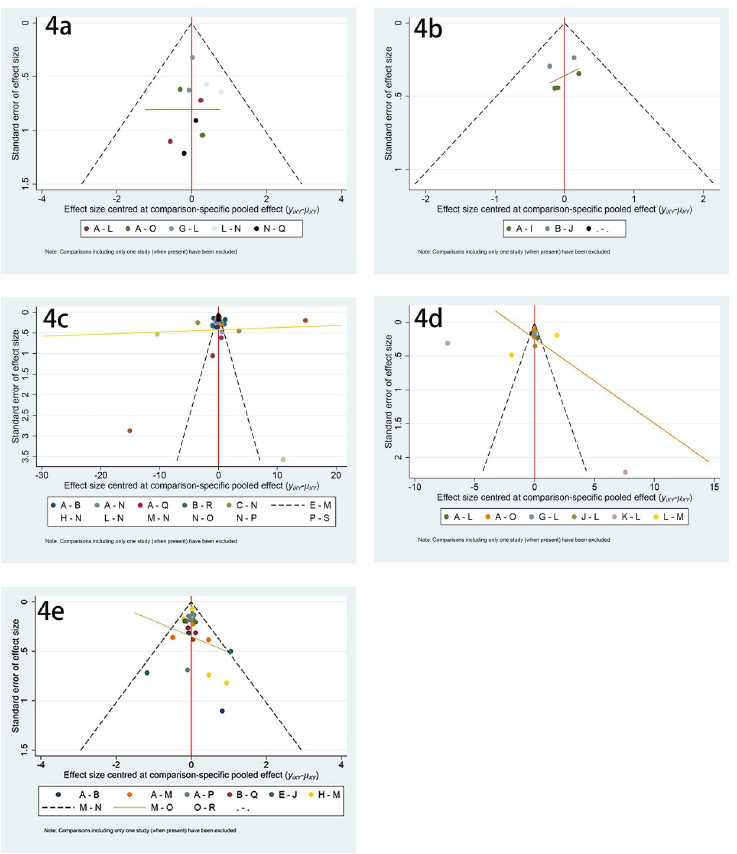
Fig 4. Funnel chart. (4a) Incidence of vertebral fractures, (4b) Incidence of non-vertebral fractures, (4c) Mean percentage change of BMD of LS from baseline, (4d) Mean percentage change of BMD of TH from baseline, (4e) Serious adverse